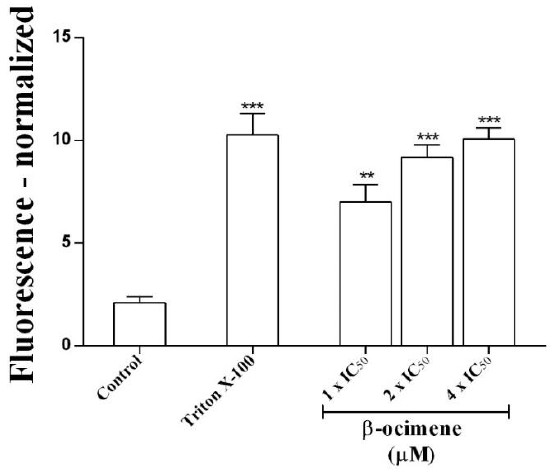
Figure 1. Effects of β -ocimene on Leishmania amazonensis promastigote plasmatic membrane perme- ability. Cells (10 6 /well) were incubated at 26 °C for 7 h in the absence or presence of β -ocimene at IC 50 , 2 × IC 50 , and at 4 × IC 50 . A SYTOX green probe was used. Data represent the normalized fluorescent mean ± standard error for three independent experiments carried out in triplicate. (**) p < 0.01 vs. control; (***) p < 0.001 vs. control.